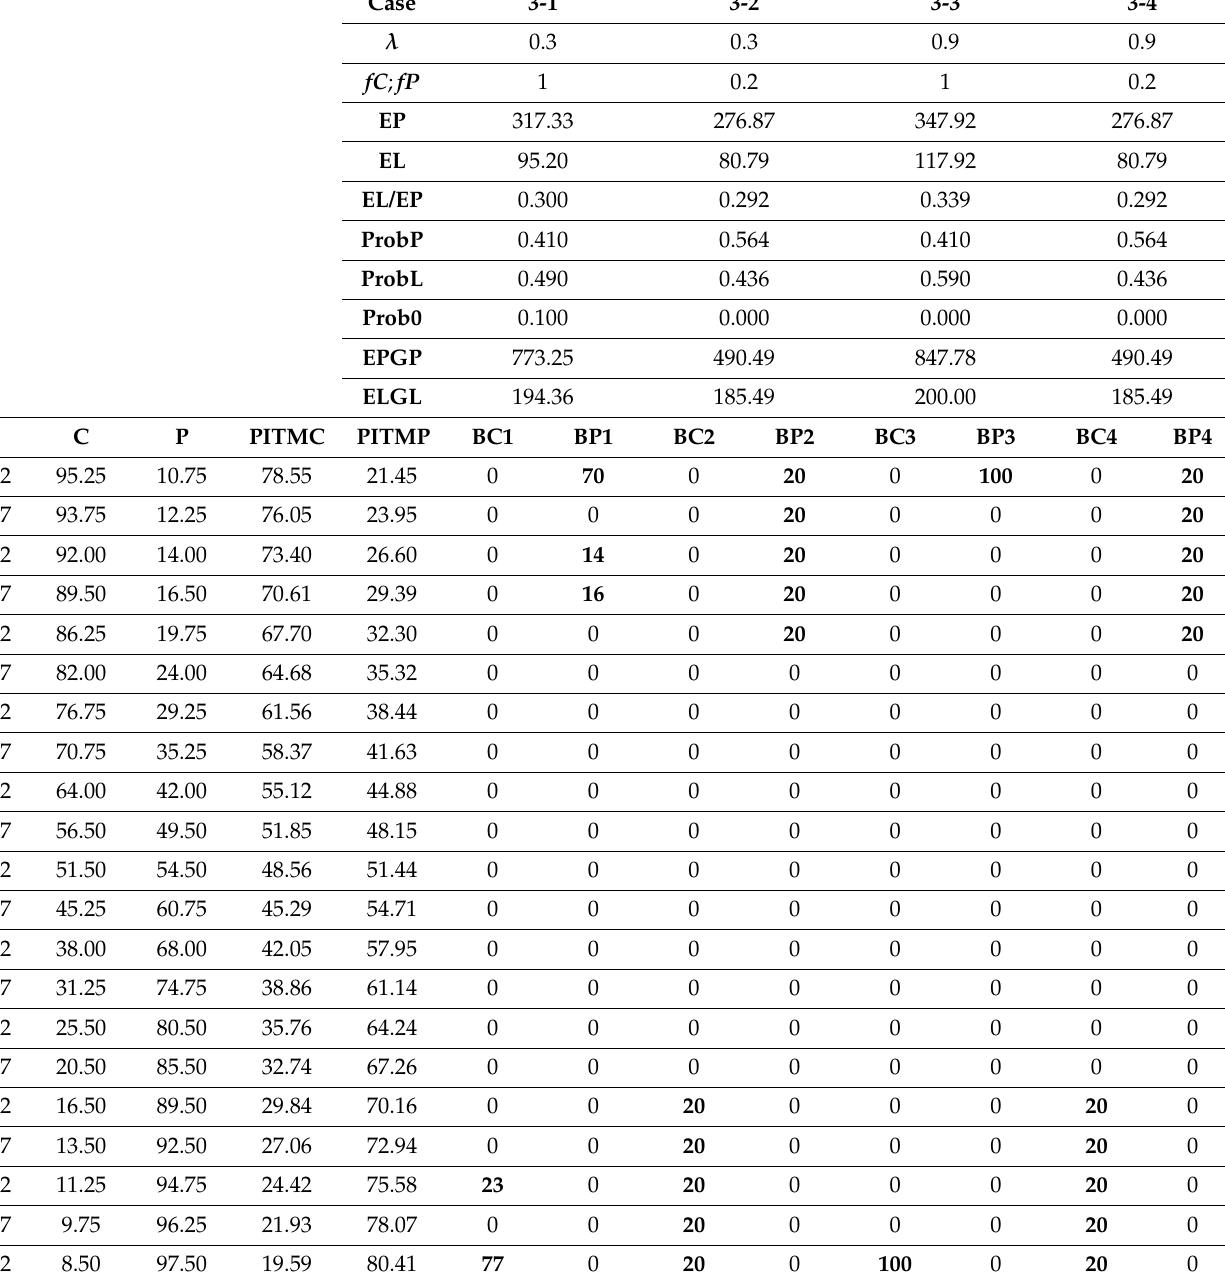
Table 4. Binary EPEL portfolio allocations and features for Case 3 with µ = − 0.0008, σ = 0.01 and S 0 = 1822 in the GBM models and with varying γ and f C , f C applied to the Nadex gold binary data of 8 February